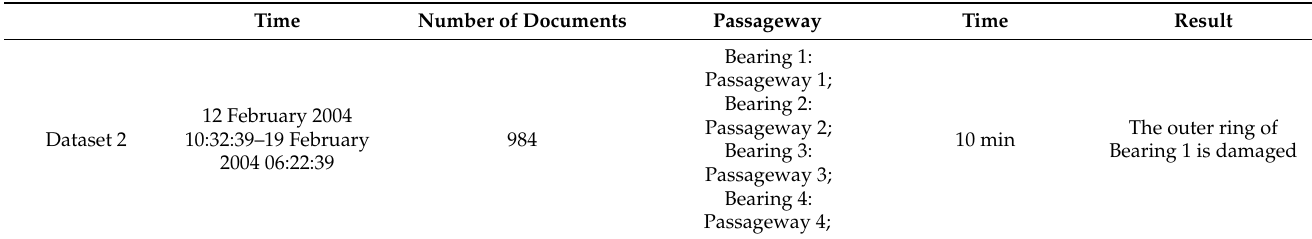
Table 3. The full-life cycle